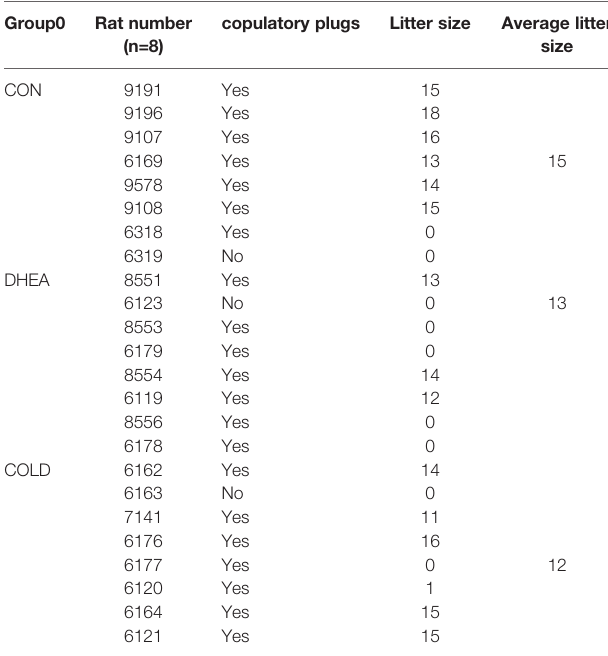
TABLE 3 | Fertility